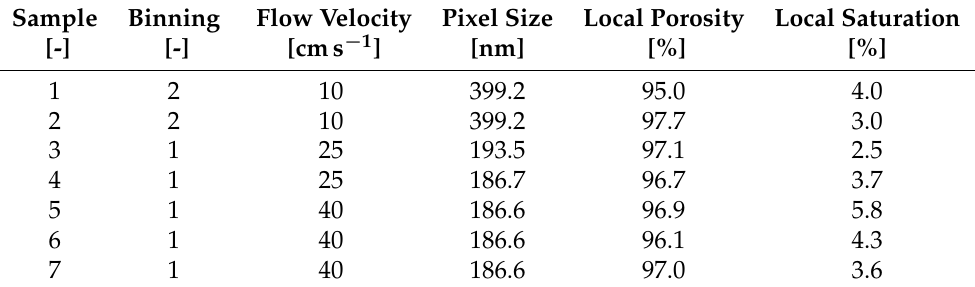
Table 1. Parameters and results for local porosity and local saturation of the µ-CT scans presented in this work.